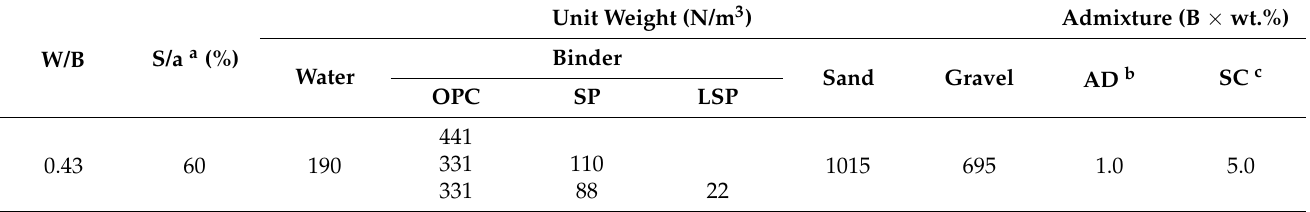
Table 4. Mix proportion of Series II (Shotcrete